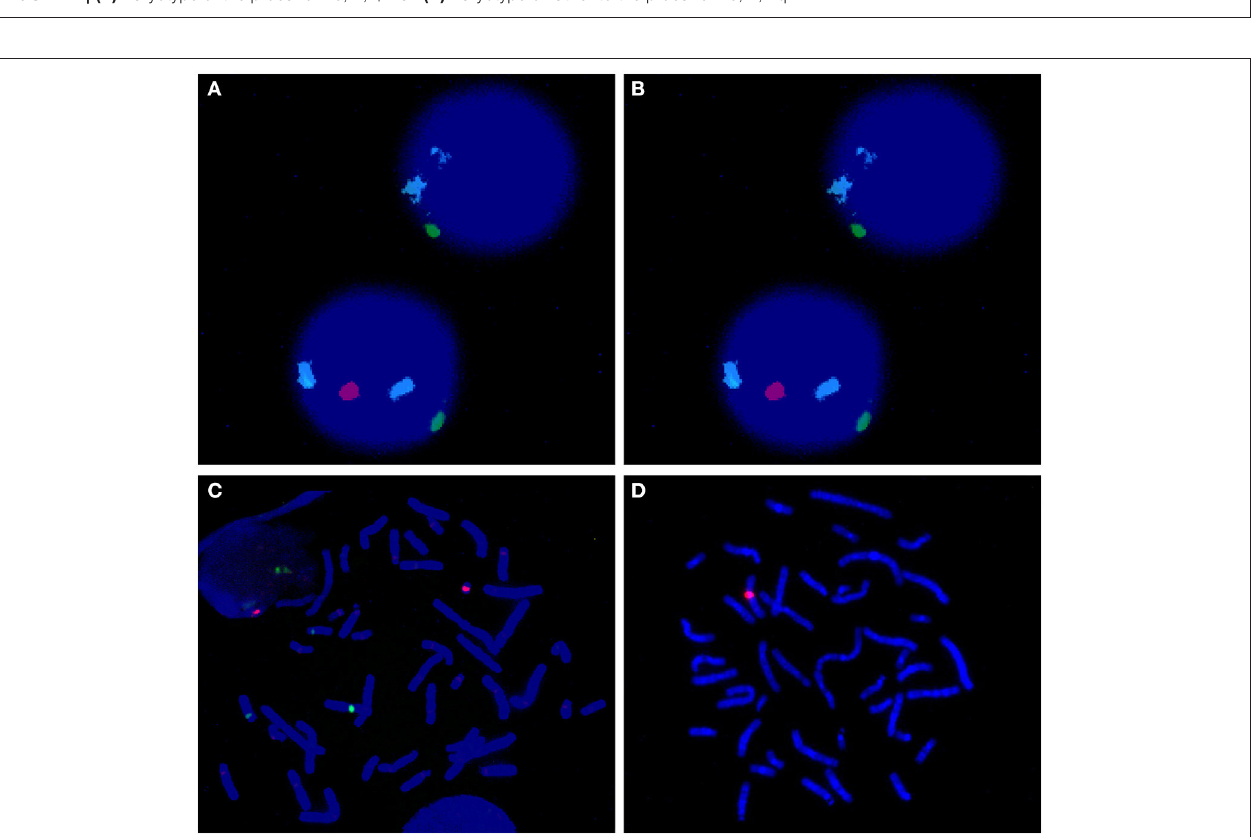
FIGURE 2 | (A) FISH of uncultured interphase cell; azure: chr18; green: chrX; red: chrY. The upper cell image shows no chrY whereas the lower cell image shows presence of chrY. (B) FISH of cultured metaphase cell; azure: chr18; green: chrX; red: chrY. These findings showed that no chrY was ppresent (implying that only X was present). (C) FISH of cultured metaphase cell; azure: chr18; green: chrX; red: chrY. These findings showed presence of chrY (implying presence of XY). (D) Yq12 FISH of cultured metaphase cell; red: chrX; green:chrY. The findings showed Yq12 deletion.